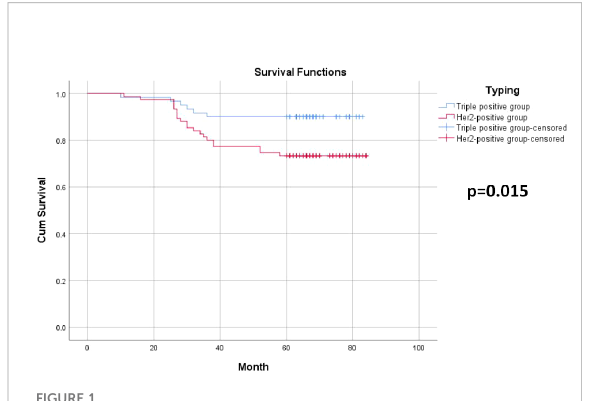
FIGURE 1 5-year disease-free survival survival curves for the two groups of breast cancer patients.